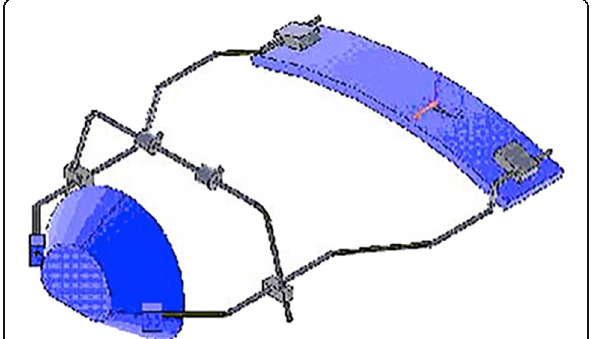
Fig. 1 3D model of Delaire FM designed by using ANSYS 5.7